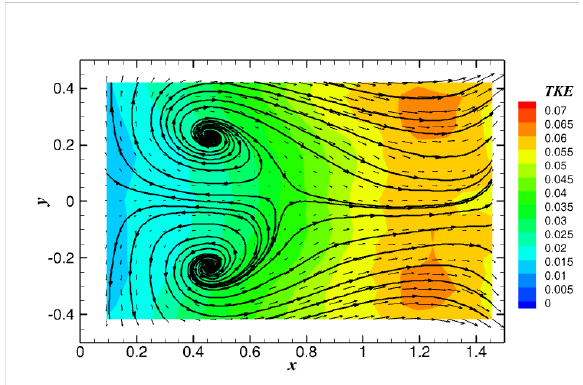
Fig. 7. Turbulence Kinetic Energy in the plane z = 1 . The distribution of TKE in the whole measured domain is shown in Figure 8, where the iso-surfaces of TKE are drawn.